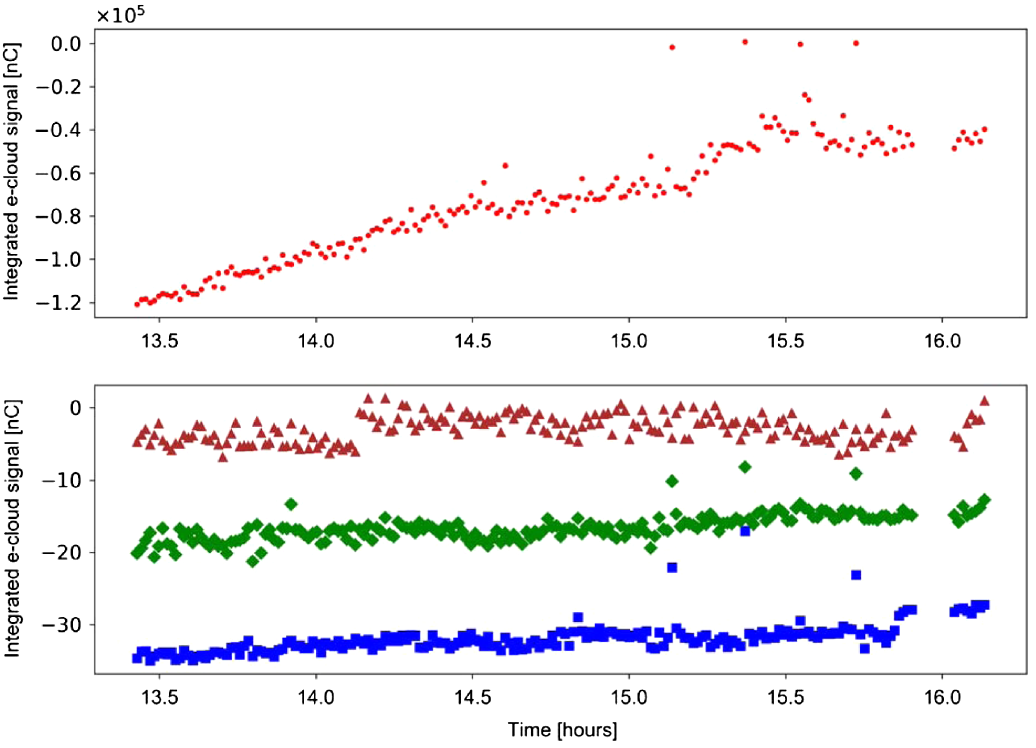
FIG. 12. Integrated signals from the ECMs during the total duration of the experiment in the SPS. (top) Reference copper liner; (bottom) liners with e-cloud mitigation: blue squares — treated by ASTeC, brown triangles — treated at the University of Dundee and green lozenges — a-C coating. Note the difference in vertical